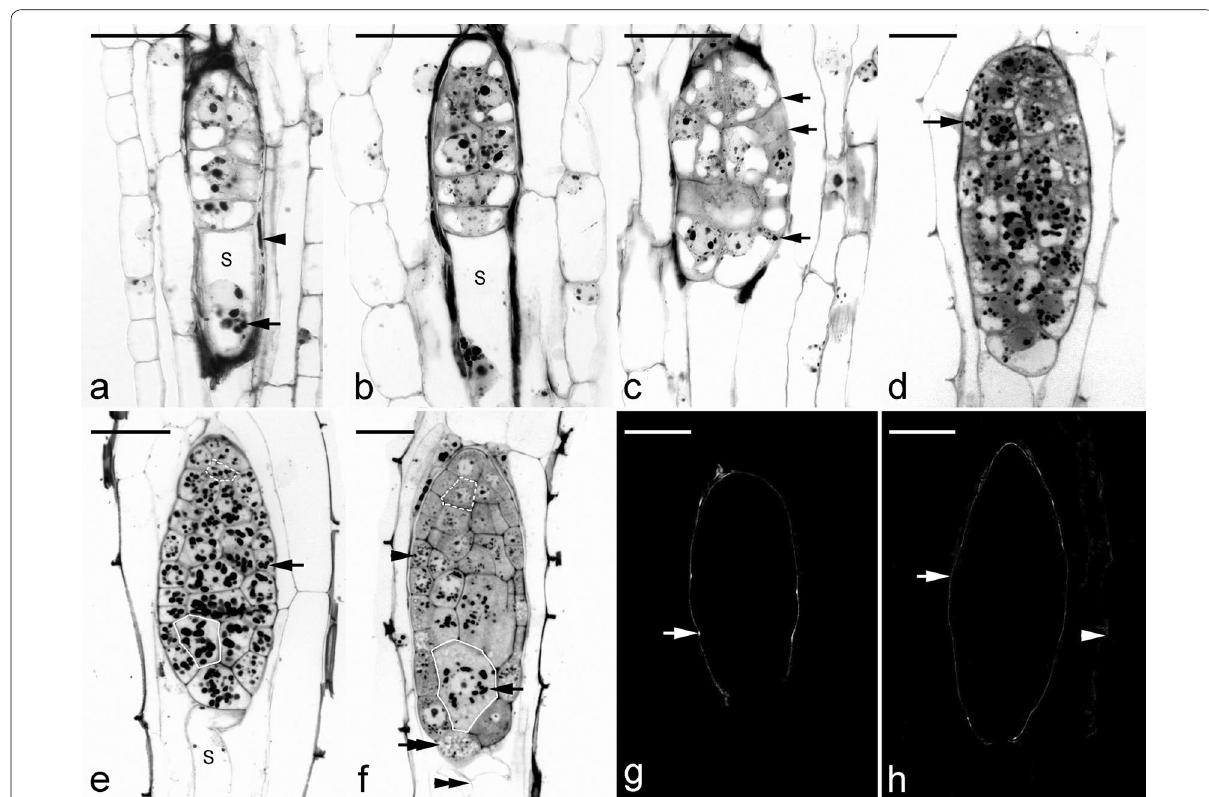
Fig. 5 Light micrographs of embryo development of A. roxburghii at the late stages. a The cell at the terminus divides vertically and increases in size in preparation for further divisions. The suspensor (S) continues to elongate and a few starch grains (arrow) accumulate around the nucleus. At this stage, the inner seed coat has degenerated (arrowhead) and has been resorbed by the developing embryo. Scale bar 30 µm. b The suspensor = has elongated further, but it never extends beyond the lumen enclosed by the outer seed coat. Scale bar 30 µm. c Additional periclinal and = anticlinal divisions within the embryo proper that result in the formation of the inner tier of cells and the protoderm (arrows). Scale bar 30 µm. = d Light micrograph showing an early globular embryo with a discernible protoderm. Numerous starch grains (arrow) accumulate within the cells of embryo proper. Scale bar 30 µm. e As the globular embryo approaches maturity, more starch grains (arrow) accumulate within the embryo = proper and the suspensor (S) is going to degenerate. Within the embryo proper, the smaller cell toward the chalazal end is marked by the dashed line and the larger cell toward the micropylar end is marked by the solid line. Scale bar 30 µm. f A longitudinal section through a mature seed. = Within the embryo proper, the smaller cell toward the chalazal end is marked by the dashed line and the larger cell toward the micropylar end is marked by the solid line. The suspensor cell (double arrowhead) became dehydrated and finally collapsed. At this stage, the starch grains (arrow) have most disappeared, and numerous small protein bodies (arrowhead) can be seen within the embryo proper. Although the lipid cannot be preserved in this historesin, the spaces between the protein bodies could be the storage lipid bodies (double arrow). Scale bar 30 µm. g Nile red = staining fluorescence micrograph of an early globular embryo at the same stage as that seen in c . The surface wall (arrow) of the embryo proper reacts positively to the stain, and the fluorescence is absent in the suspensor wall. Scale bar 30 µm. h Nile red staining fluorescence micrograph = of a globular embryo at the same stage as that seen in e . The surface wall (arrow) of the embryo proper reacts positively to the stain, and seed coat (arrowhead) only reacts weakly. Scale bar 30 =